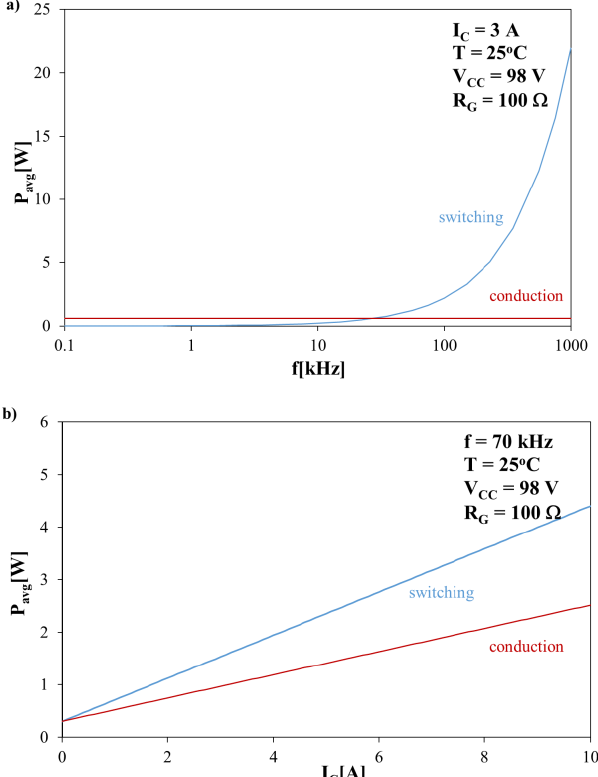
Figure 11. Computed dependences of the IGBT power losses caused by its switching (blue line) and conducting (red line) on frequency ( a ) and the collector current ( b ).